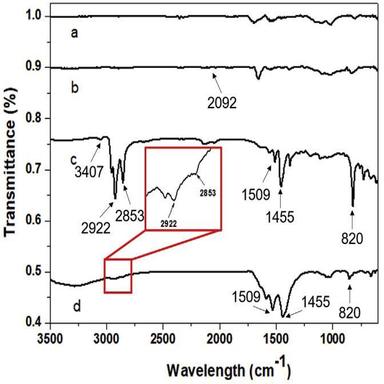
Infrared spectra of P3HT-MWCNT prepared by click chemistry: (a) MWCNT; (b) azidated MWCNT; (c) pure P3HT; (d) P3HT-MWCNT.